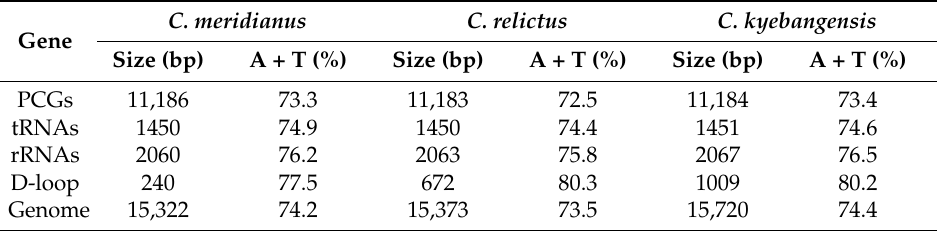
Table 1. Size, AT content (%) for C. meridianus , C. relictus , and C. kyebangensis mitogenomes.